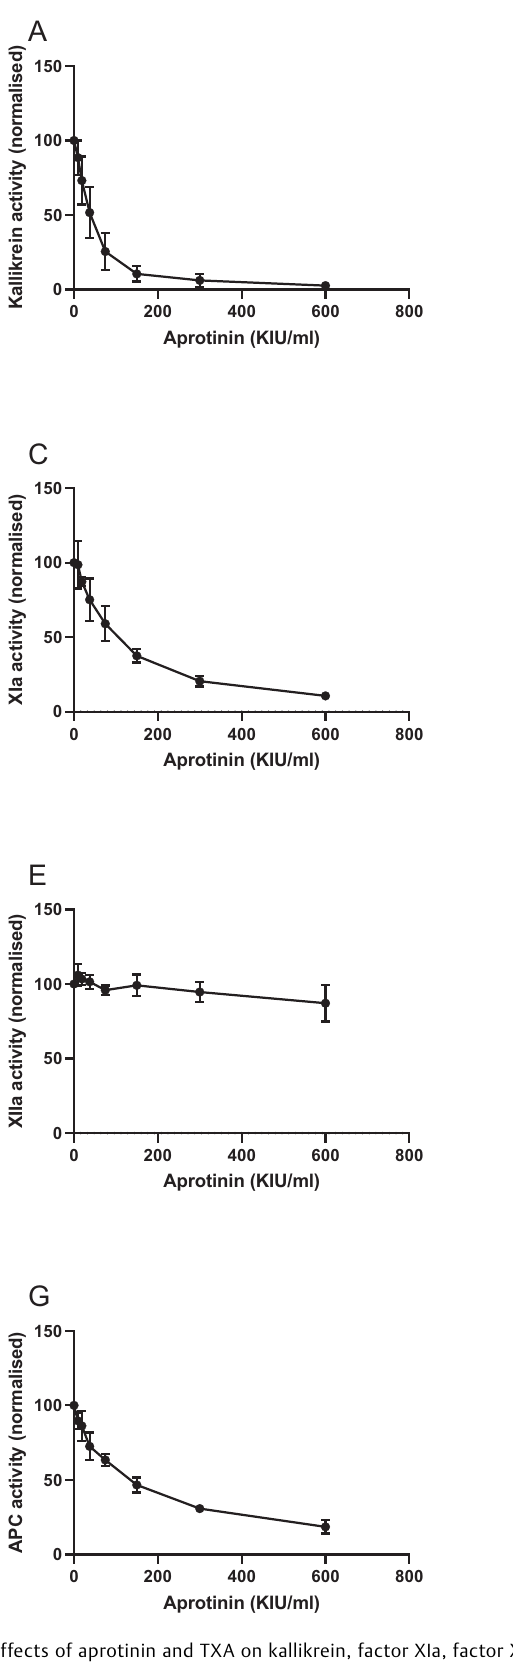
Fig. 6 Effects of aprotinin and TXA on kallikrein, factor XIa, factor XIIa, and activated protein C. Aprotinin or TXA were added in increasing concentrations to puri fi edactivated coagulation factors, after which enzymeactivities were determined usinga chromogenic substrate. Activity levels in the absence of aprotinin or TXA were set at 100. Shown are mean values of 3 independent experiments performed in duplicate.